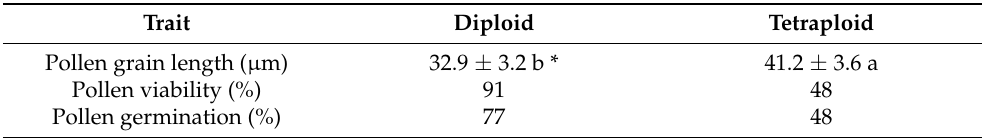
Table 5. Pollen grains characteristics of diploid and the tetraploid clone 4x-14 of the apple cv.